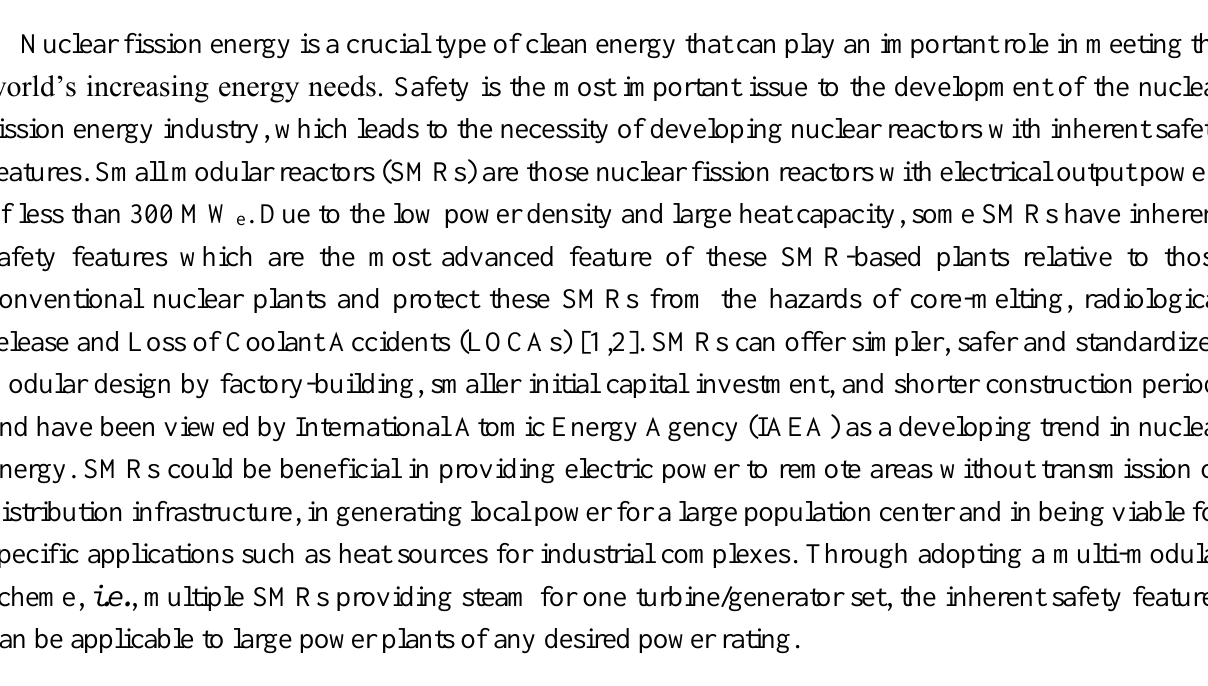
Figure 1. Schematic View of a MHTGR-based